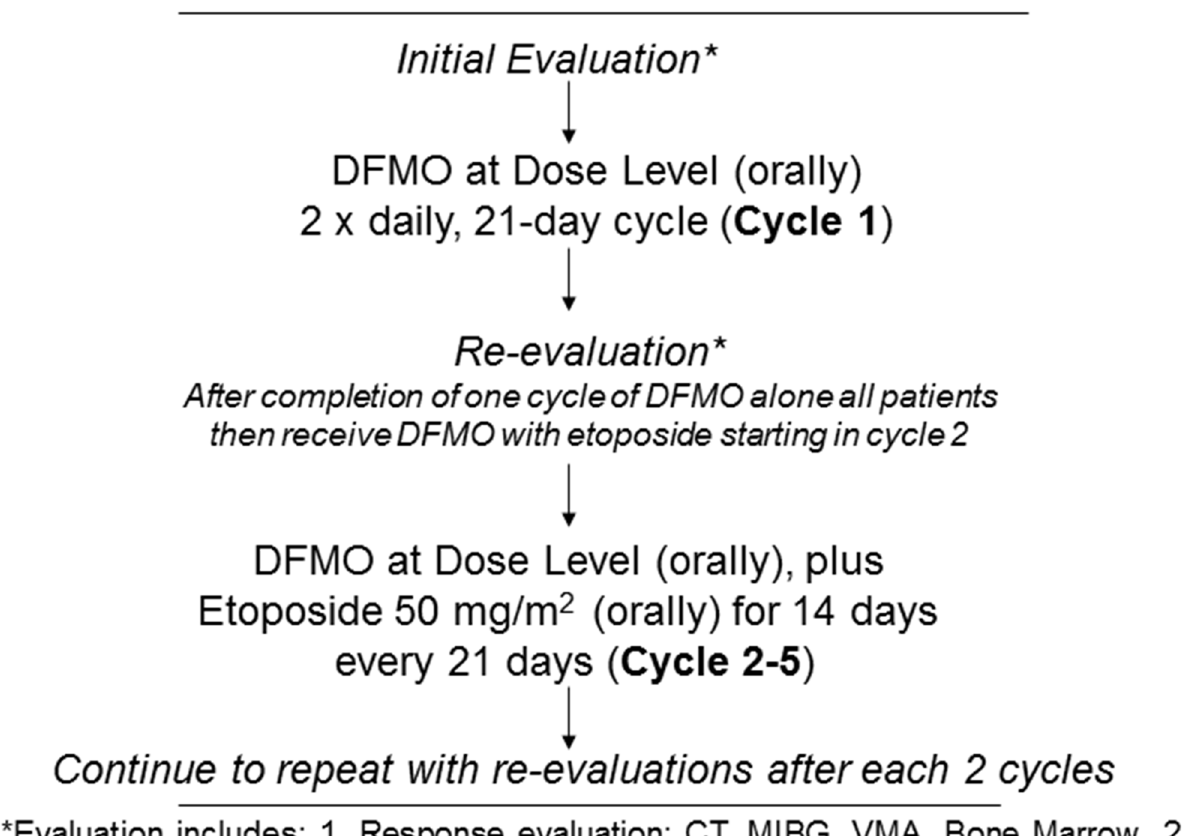
Fig 2. Flowchart of NMTRC 002 — Safety Study for Refractory or Relapsed Neuroblastoma With DFMO Alone and in Combination With Etoposide.